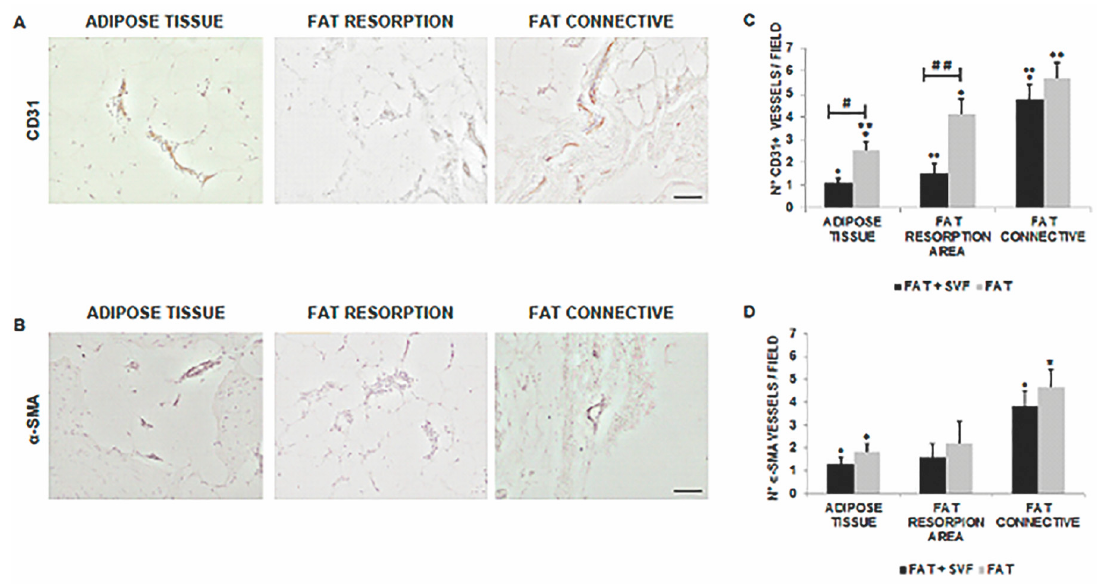
Figure 8. ( A , B ) displayed representative 100× magnification images of AT, fat reabsorption area and CT stained for CD31 (brown color; DAB as chromogen) and α -SMA (black color; DAB-Nickel as chromogen) within a mastectomy flap biopsy. ( C , D ) show the results of comparison between the two groups. The statistical symbols *, **; •, •• and #, ##, indicate the maximum value and differences between study and control group. *, • are maximum values; **, •• are two values above the limit; # indicate marked difference between the study group and the control group; ## very marked difference between the study group and the control group.